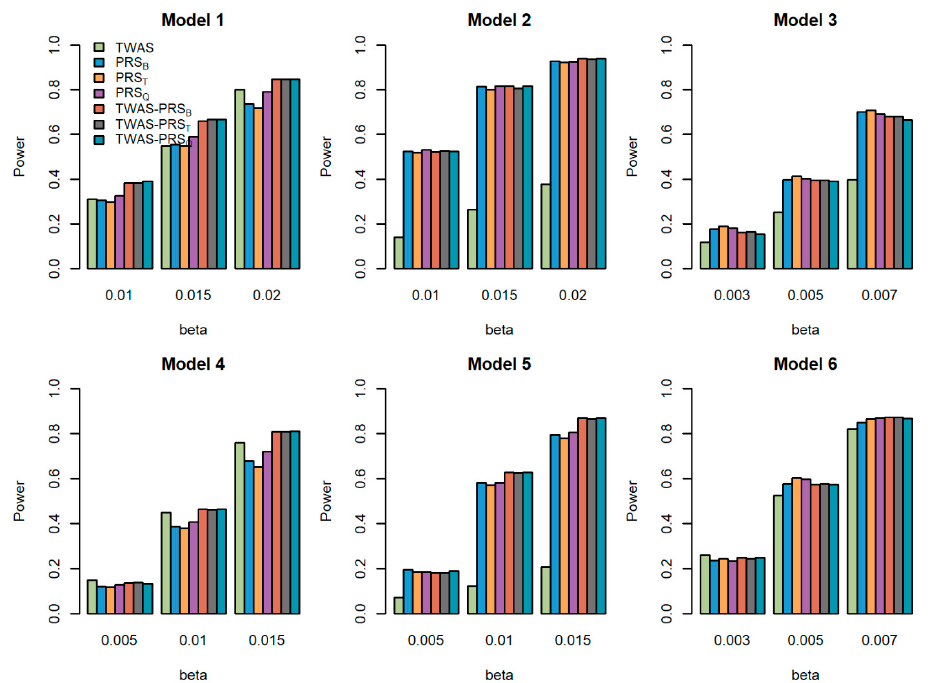
β Figure 3. Powers of the seven tests versus the total effect size for quantitative traits with Figure 3. Powers of the seven tests versus the total effect size β for quantitative traits with N = 20,000 20,000 N = . The proportion of causal variants is 0.2. Models 1–3 correspond to genes 1–3, for which we only use the eQTL with the largest weight to generate gene expression; Models 4–6 correspond to genes 1–3, for which we use two eQTLs with the first two largest weights to generate gene